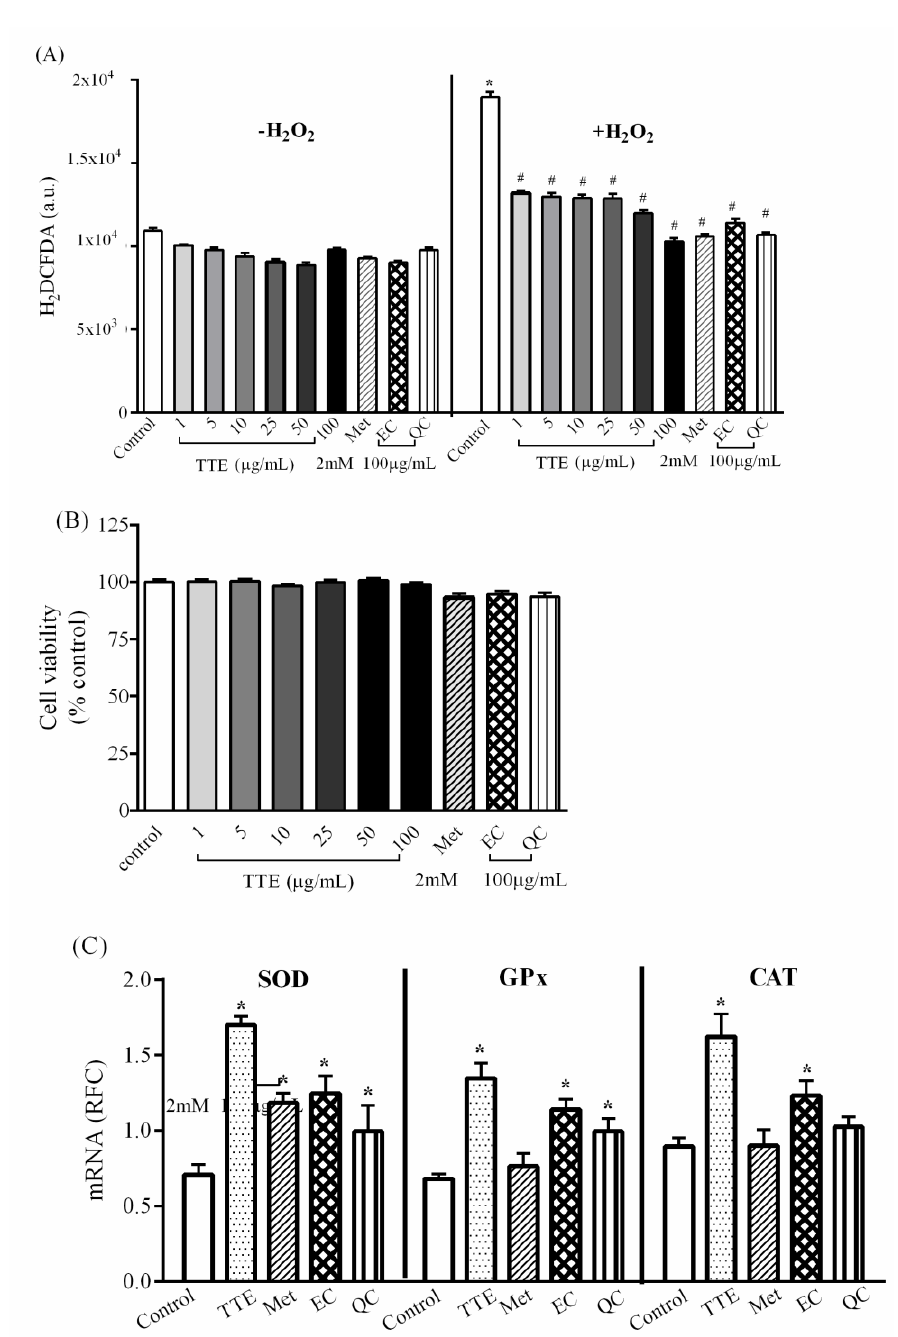
Figure 2. The effect of TTE on H 2 O 2 -induced oxidative stress and cell viability in HepG2 cells. ( A ) HepG2 cells were pretreated with 100 µ g/mL TTE, epicatechin (EC), quercetin (QC), and 2 mM metformin (Met) for 24 h. The cells were subsequently incubated with H2DCFDA. The fluorescence DCF was subsequently detected. * p < 0.05 vs. control without H 2 O 2 , # p < 0.05 vs. cells treated with H 2 O 2 alone. ( B ) The cells were incubated with 1–100 µ g/mL TTE, EC, QC, and 2 mM metformin (Met) for 24 h, and the cell viability was assessed using MTT assay. ( C ) mRNA expression levels of antioxidant genes, including copper-zinc superoxide dismutase (Cu-ZnSOD), glutathione peroxidase (GPx), and catalase (CAT) in HepG2 cells. Total RNA was extracted from HepG2 cells, and mRNA levels were measured using quantitative real-time PCR (qPCR) The results are reported as relative fold change (RFC) and expressed as mean ± standard error of mean (SEM) ( n = 5). * p < 0.05 vs. control cells.